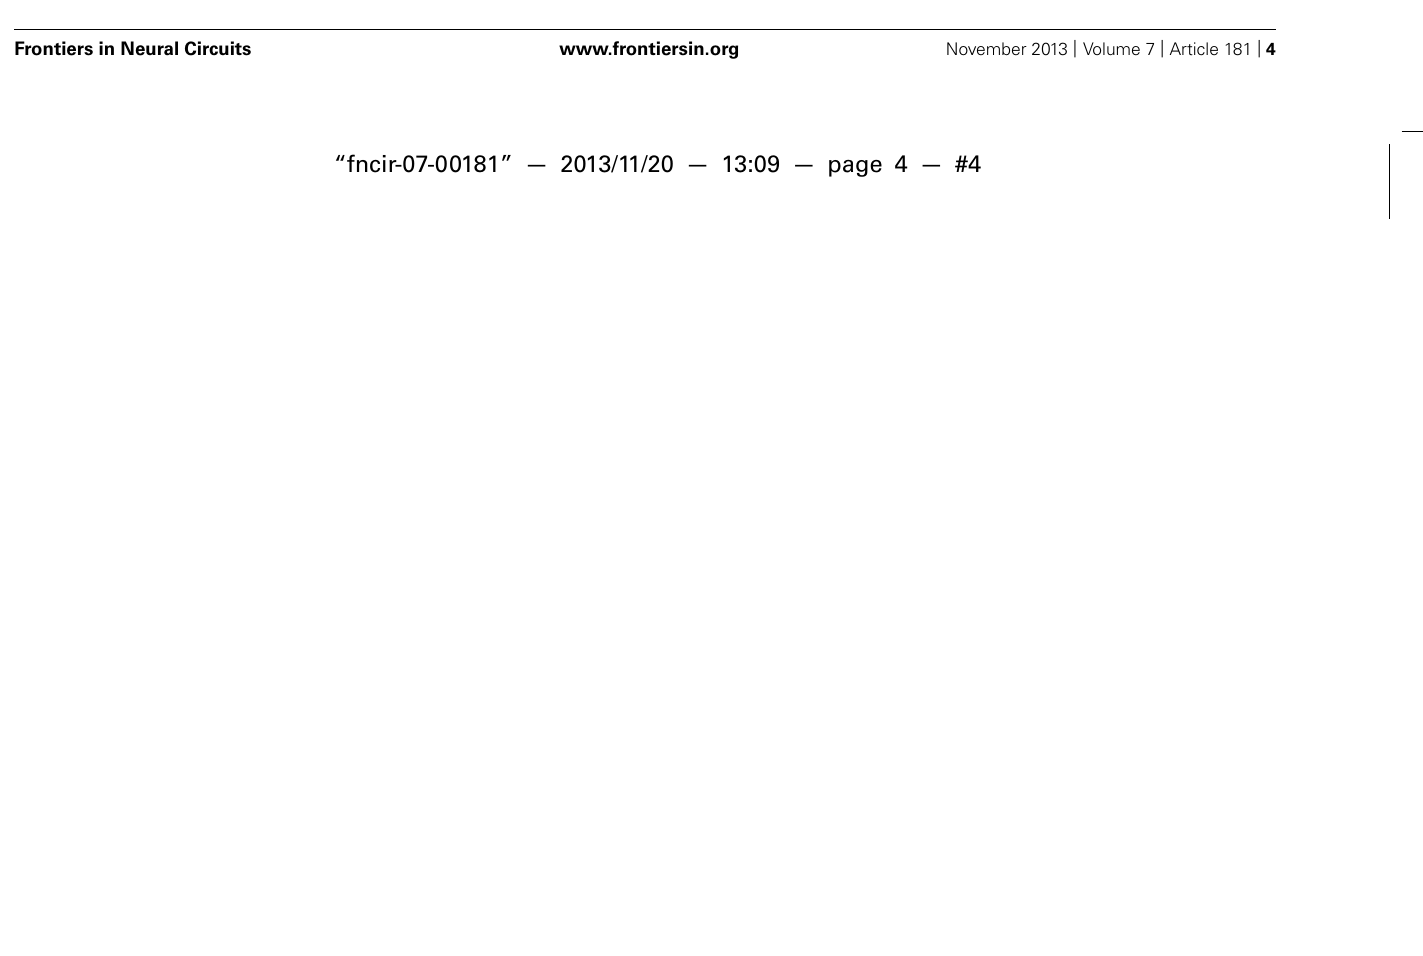
and standard error of peak-trough time for pyramidal cells ( n = 53, 567 ± 8.68 μ s), interneurons ( n = 5, 241 ± 14.1 μ s), and putative axons ( n = 64, 176 ± 4.84 μ s) recorded in the medial white matter (MWM), alveus, and pyramidal cell layer of the hippocampus; (D) Scatter plot of signal to noise ratios for individual units against peak-trough time for SDWs recorded in MWM, alveus, and CA1 of the hippocampus, as well as pyramidal cells (PYR) and interneurons (INT) in CA1 of the hippocampus. The SDWs, and pyramidal cells clearly cluster by peak-trough time while interneurons overlap with the longer